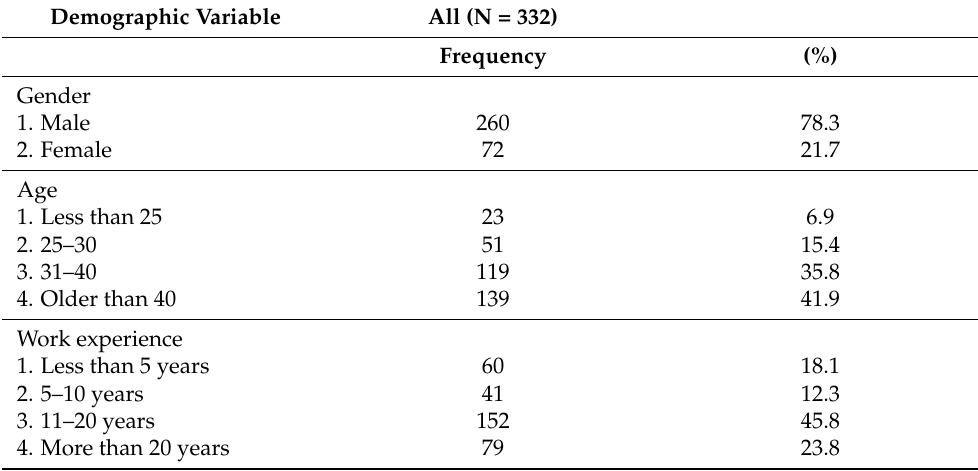
Table 2. Demographic information.